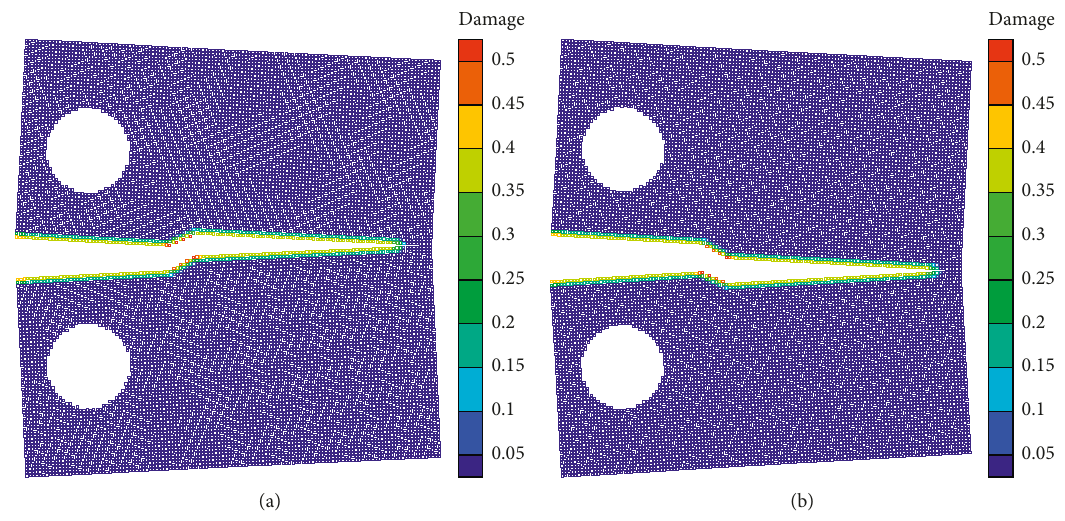
Figure 11: Quasistatic rack paths for (a) sample 1 and (b) sample 4.